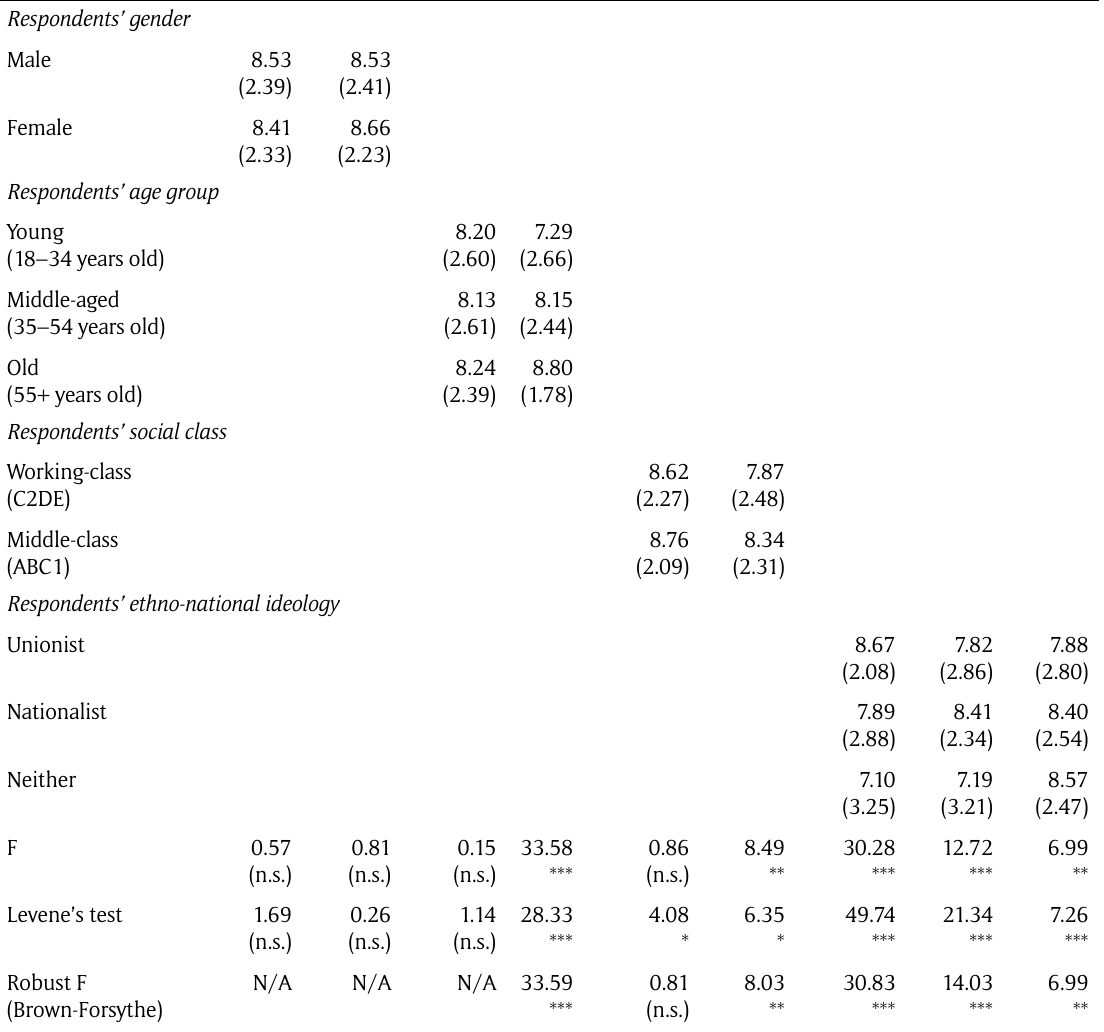
Table 2: Preferred composition of citizens’ assemblies